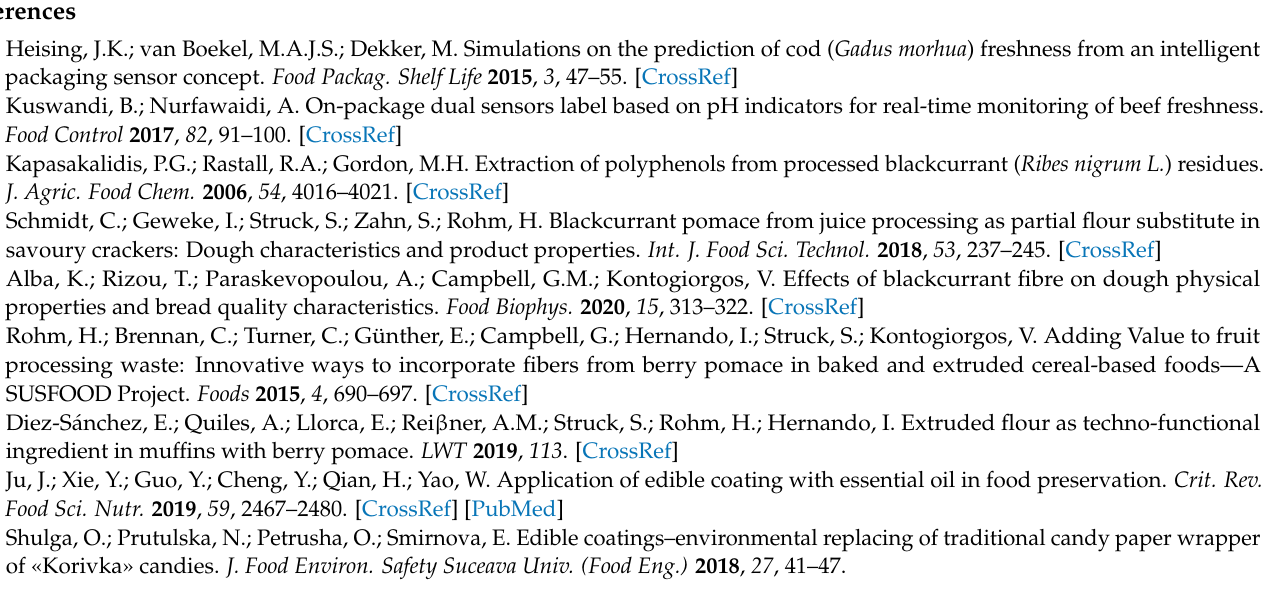
Supplementary Materials: Figure S1: Photos of chitosan and pectin films with blackcurrant